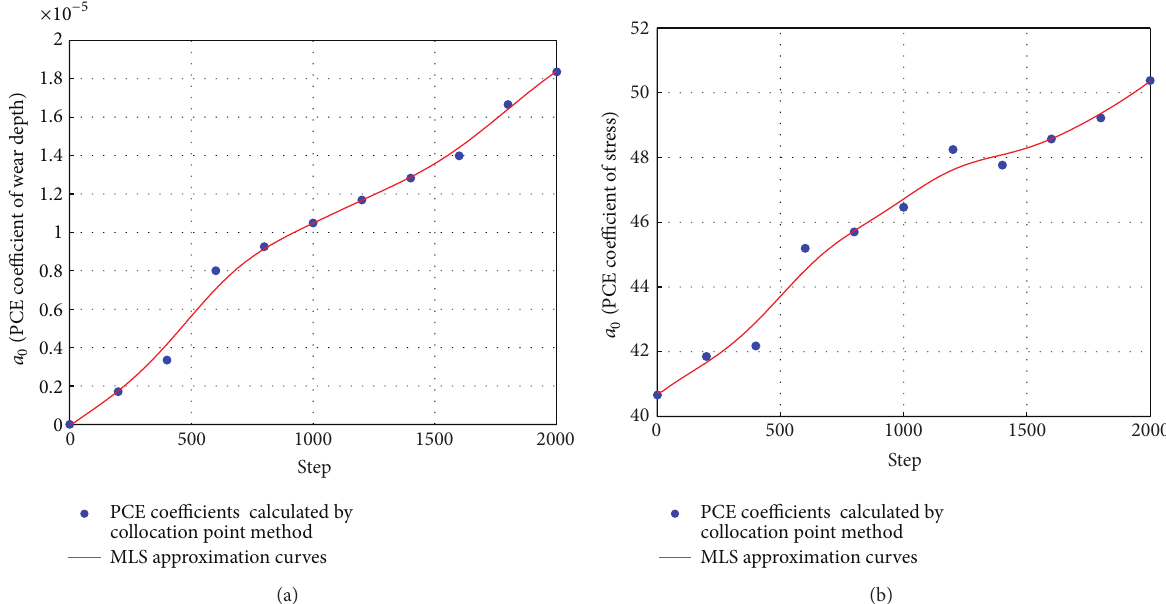
Figure 9: Examples of MLS approximation curves for PCE coefficients of the wear depth and the stress of lug. (a) MLS approximation curve for 𝑎 0 of the wear depth PCE; (b) MLS approximation curve for 𝑎 0 of the stress of lug PCE.